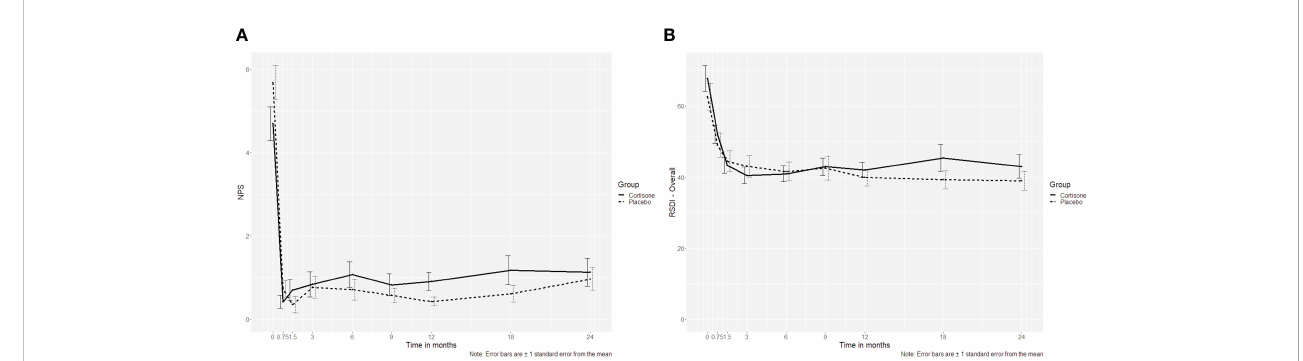
FIGURE 2 Line plot of (A) the nasal polyp score (NPS) over the 2-year follow-up showing no interaction between the steroid and the placebo group (p=0.507), (B) Rhinosinusitis Disability Index (RSDI, p= 0.433) over the 2-year follow-up showing no interaction between the steroid and the placebo group; the dotted line represents the placebo group, the continuous line represents the steroid group.